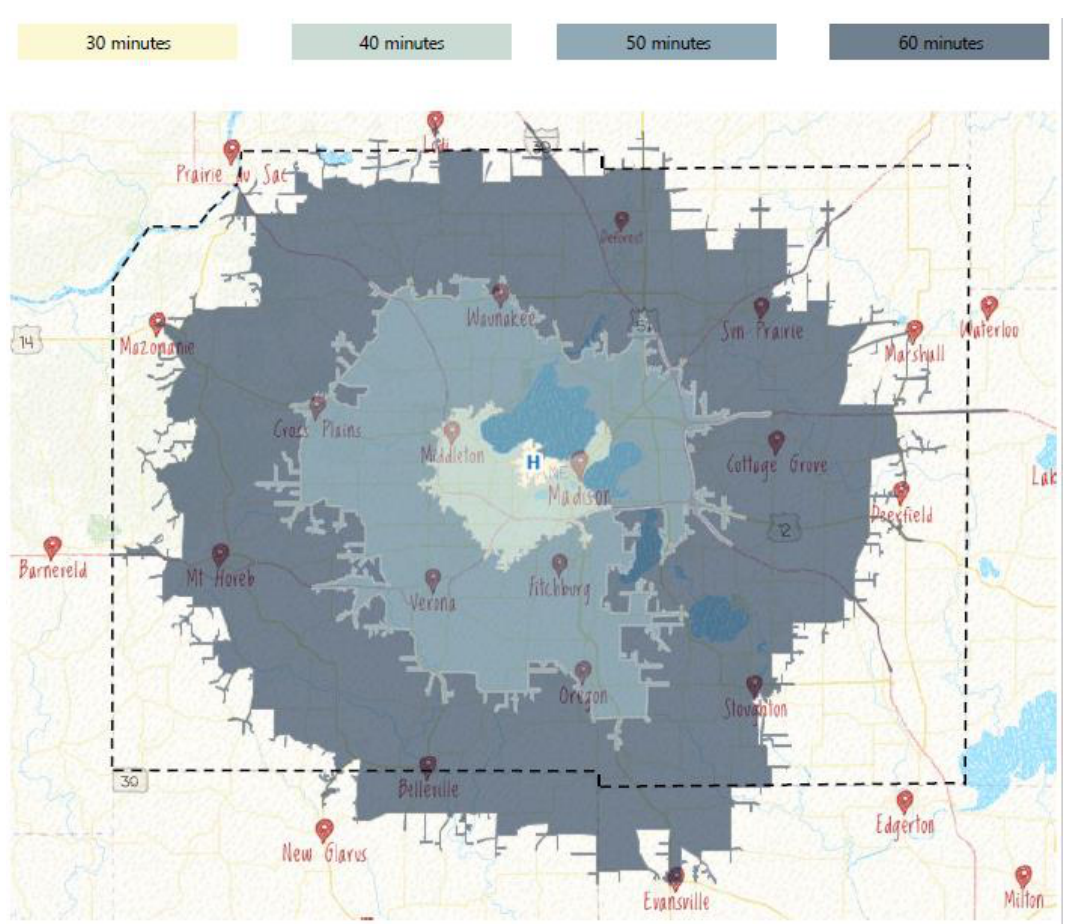
Figure 2. Projected time from witnessed arrest to ECMO cannulation. This map describes time-to- ROEC for patients, assuming a 2-min delay in calling 911. It integrates historic scene–response time based on geographic location (typically <5 min county-wide), a 16-min on-scene resuscitation by paramedics, rapid transport back to the Emergency Department (drive-times are based on Wednesday at 0830, the 75th percentile for this metric), and a 15 min door-to-cannulation time. The latter is ambitious, but in line with our simulated and historic times. Color-coded boxes reflect the minimum projected time-to-ROEC. Accordingly, the outer “60 min” area is considered feasible only under ideal circumstances and for excellent ECPR